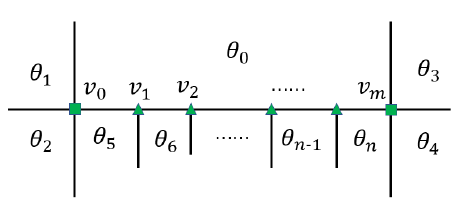
Figure 7. The T-structure T k + 1 .